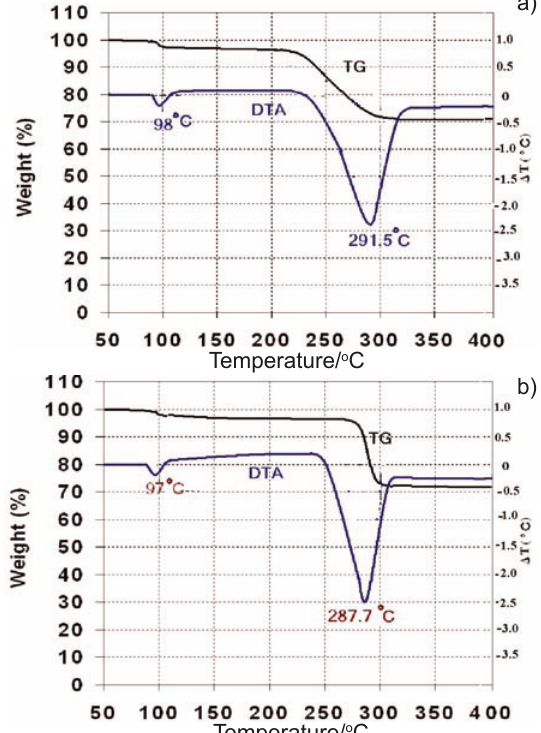
Figure 2. TG and DTA Curves for Basic Copper Carbonate (a) Microparticles (with 1 micron average particle size) (b) Nanoparticles (with 70 nm average particle size); (Sample Weight 2.0 mg; Heating Rate 10˚C min -1 ; Air Atmosphere). Fig. 2a represents the TG-DTA curves of Cu(OH) microparticles. There is a small, broad DTA endotherm below 100ºC, which corresponds to a mass loss of about 2.5% (moisture loss). The results of TG-DTA for microparticles sample showed that the major endothermic decomposition occurred around